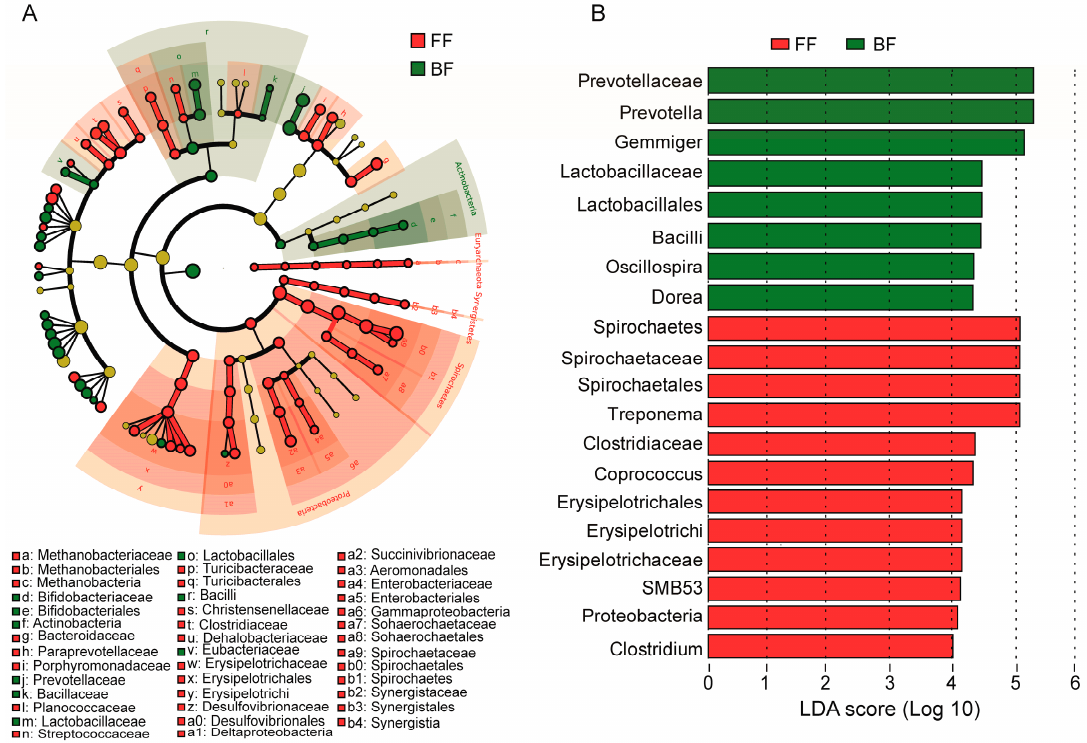
Figure 4. Differential microbiota: ( A ) Discriminant analysis of microbiota enrichment; ( B ) Linear discriminant analysis (LDA) effect size (LEfSe). Only the logarithmic LDA scores > 4 are shown for demonstration and clarity.